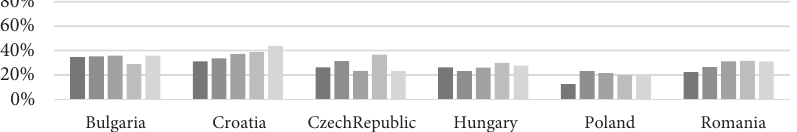
PANEL D. OUTER PERIPHERY /